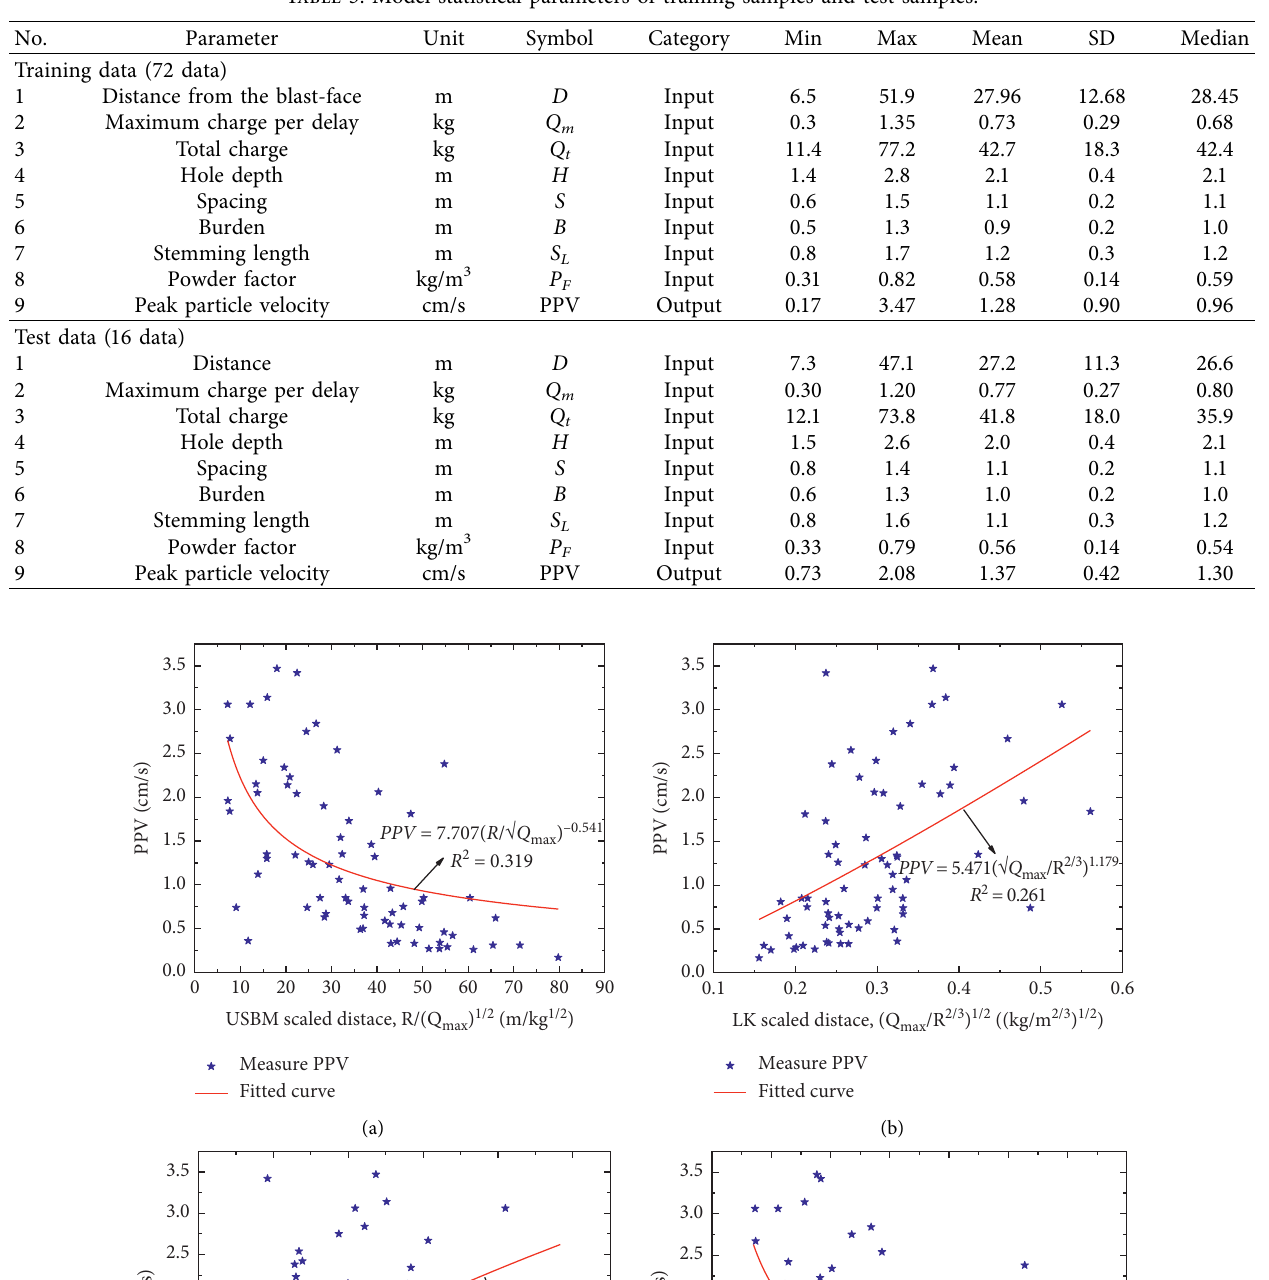
Table 3: Model statistical parameters of training samples and test samples.